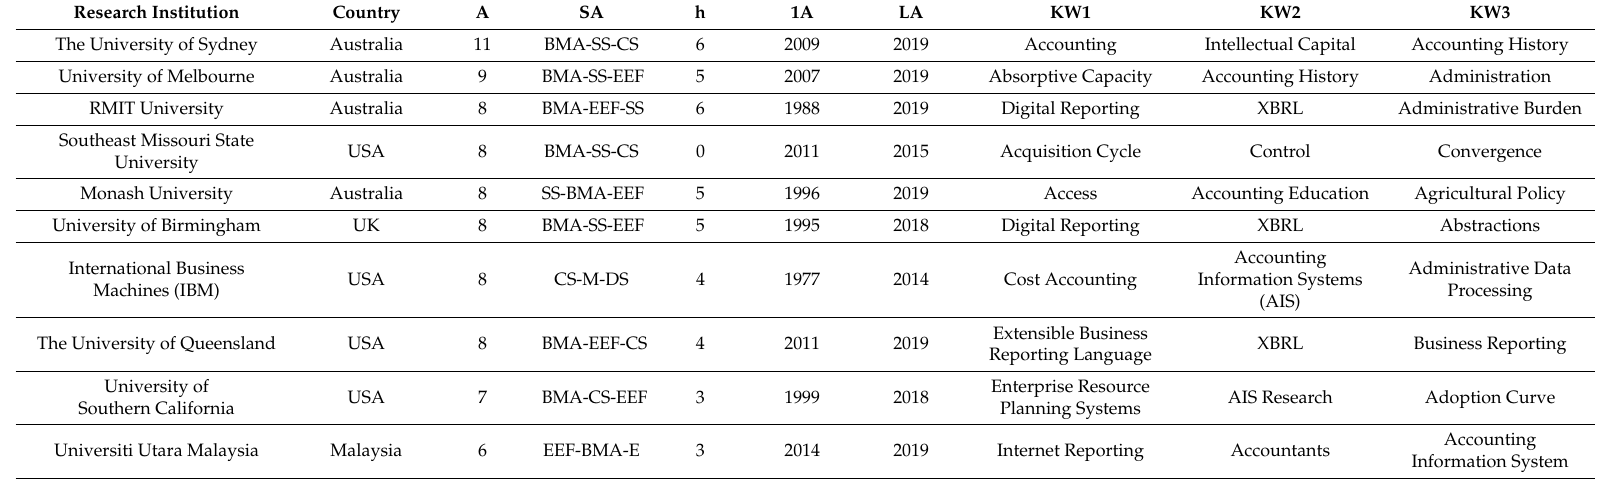
Table 3. Top 10 research institutions